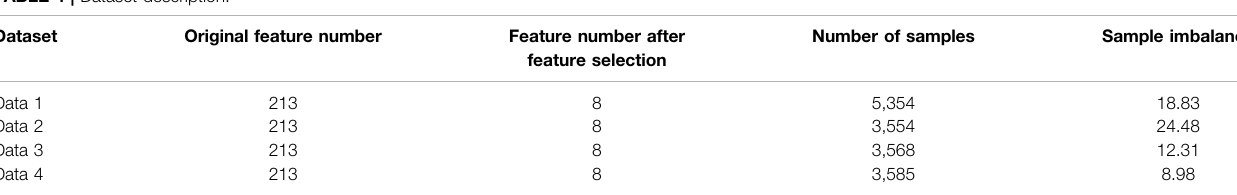
TABLE 4 | Dataset description.